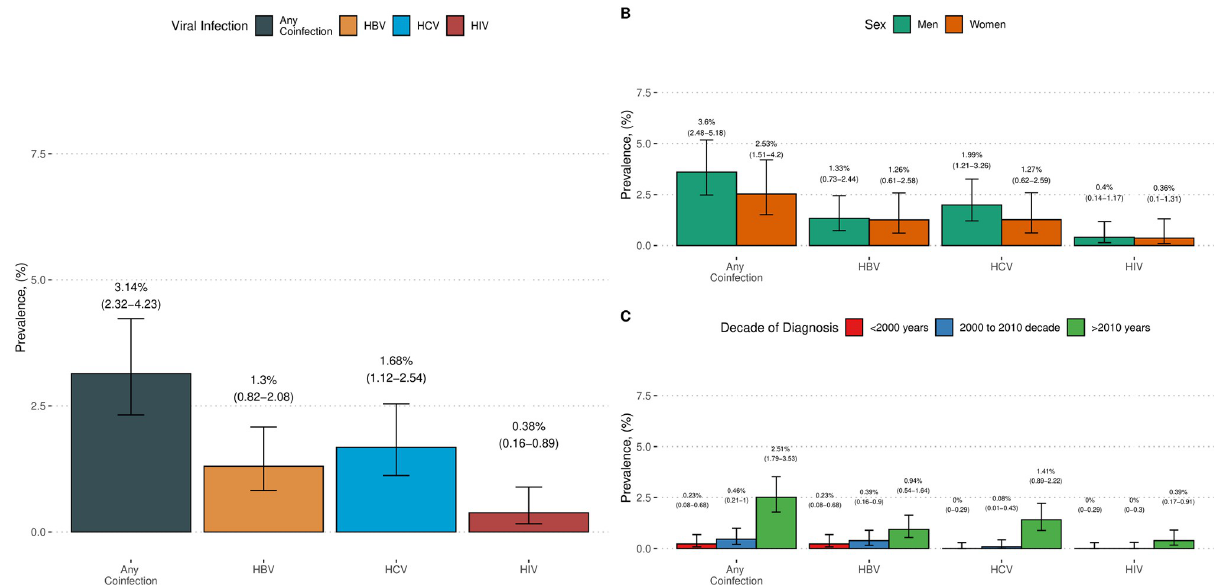
Fig 2. Estimated prevalence with 95% confidence intervals for any coinfection associated with HBV, HCV, and HIV. Abbreviations : HBV = Hepatitis B Virus, HCV = Hepatitis C Virus; HIV = Human Immunodeficiency Virus. Confidence intervals were calculated using the “Wilson”